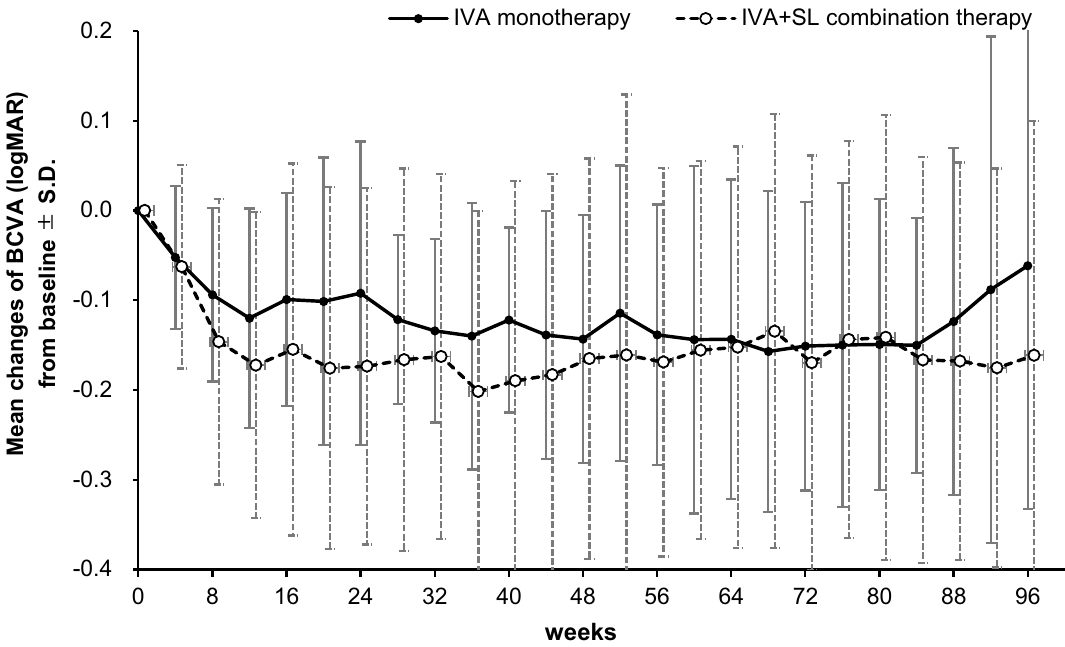
Figure 4. Mean changes of the BCVA from baseline in logMAR units for IVA monotherapy group and IVA + SL combination therapy group. IVA intravitreal aflibercept; SL subthreshold laser; BCVA best-corrected visual acuity; logMAR logarithm of minimum angle of resolution; S.D. standard